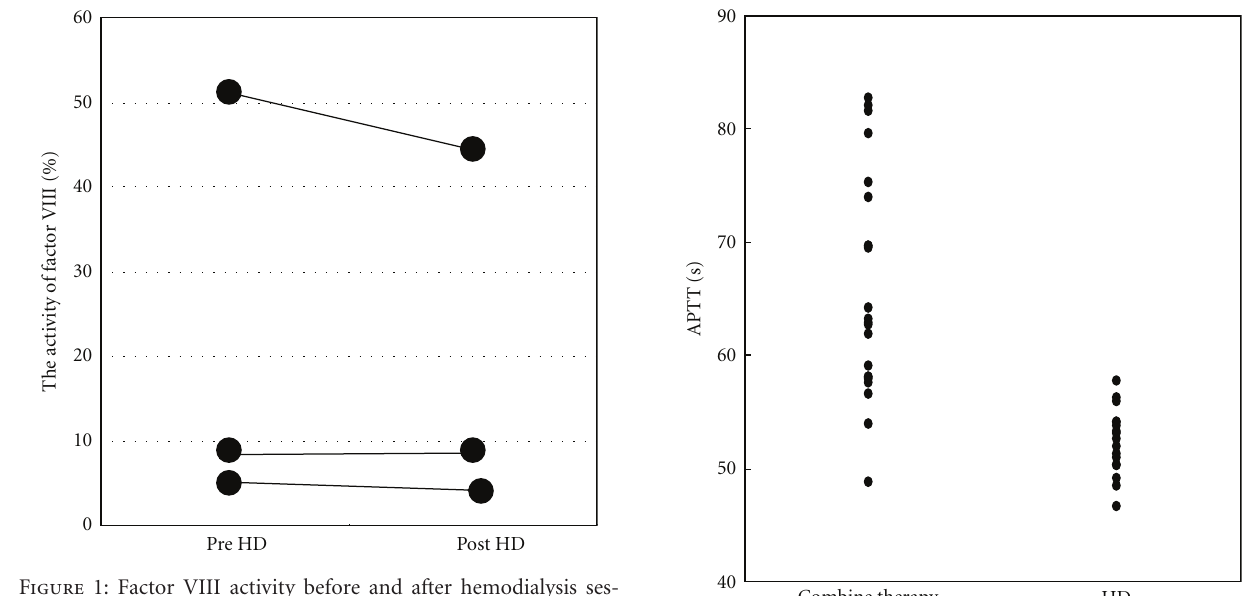
Figure 1: Factor VIII activity before and after hemodialysis ses- sions.